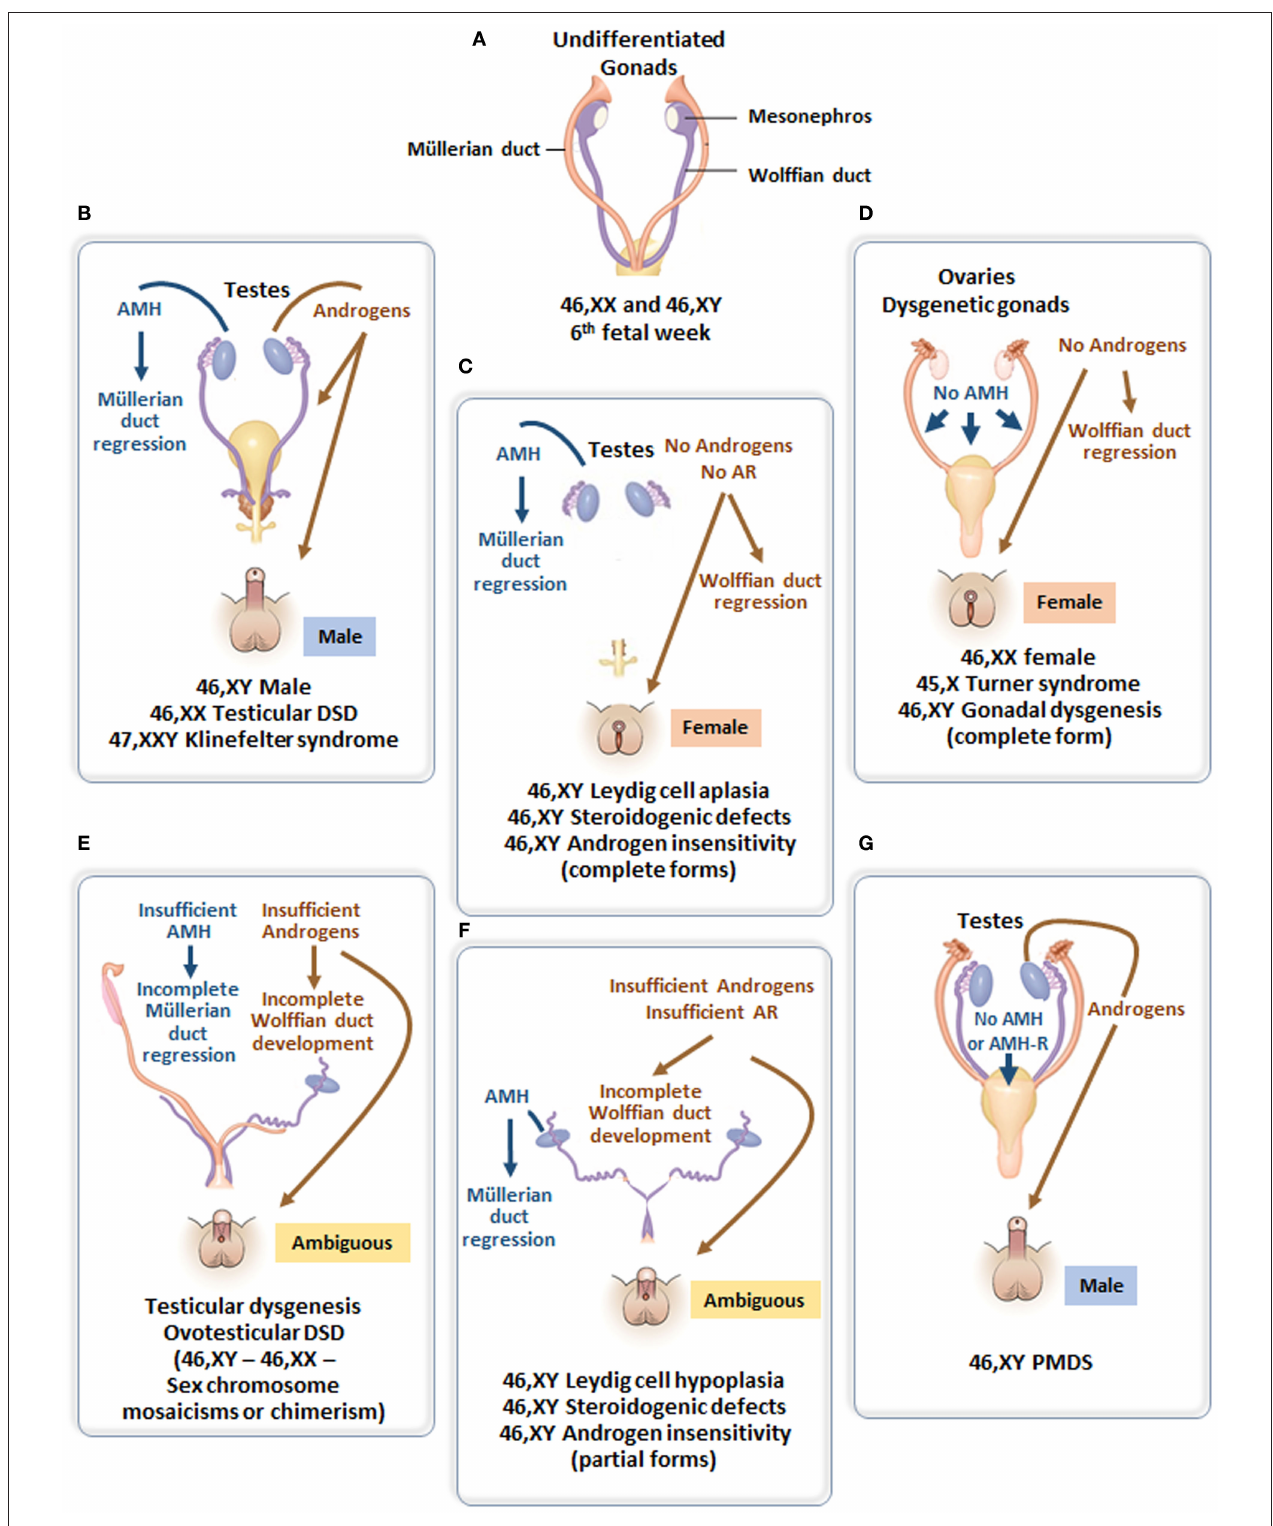
FIGURE 4 | (A) Undifferentiated stage of fetal sex development. (B) Male differentiation in normal 46,XY individuals and patients with 46,XX testicular DSD or Klinefelter syndrome. (C) Female external genitalia in patients with 46,XY DSD due to impaired androgen synthesis or action. (D) Female genital differentiation in normal 46,XX individuals and patients with dysgenetic DSD associated with 46,XX, 45,X or 46,XY genotypes. (E) Ambiguous external genitalia in patients with testicular or ovotesticular dysgenesis with different karyotypes. (F) Ambiguous external genitalia in patients with 46,XY DSD due to impaired androgen synthesis or action. (G) Male external genitalia and persistence of Müllerian ducts in 46,XY patients with AMH or AMHR2 gene defects.